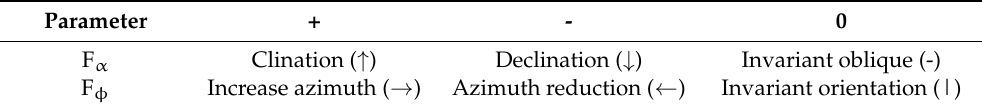
Table 1. Symbols and nature relations of F α and F φ .